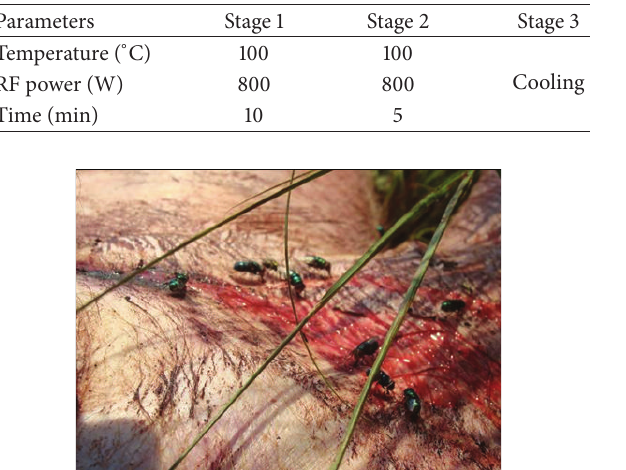
Table 2: Main microwave operating conditions.